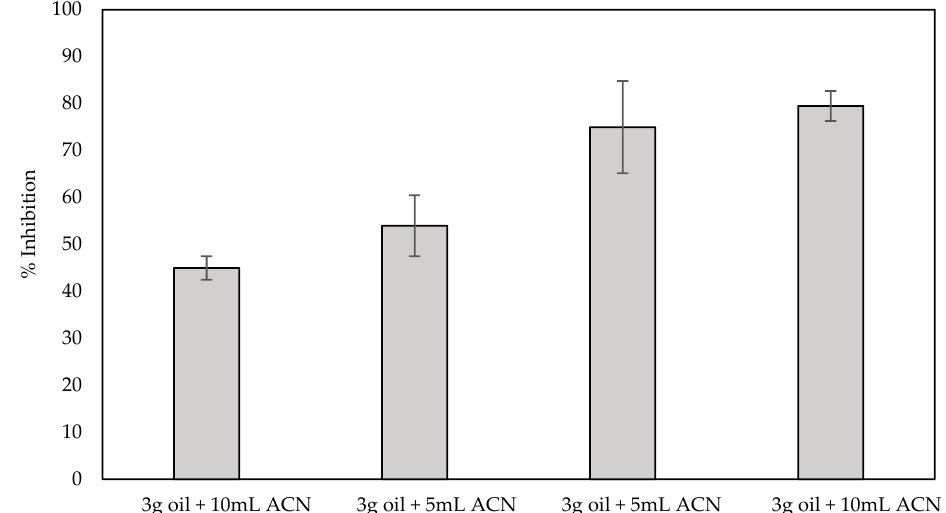
Figure 9. % Inhibition of AChE by 1 ppm carbofuran extracted from spiked olive oil. Four different ratios of sample:organic solvent were tested, and all measurements were recorded with fCB/CS/AChE-modified LIFT-spotted electrodes in triplicate.